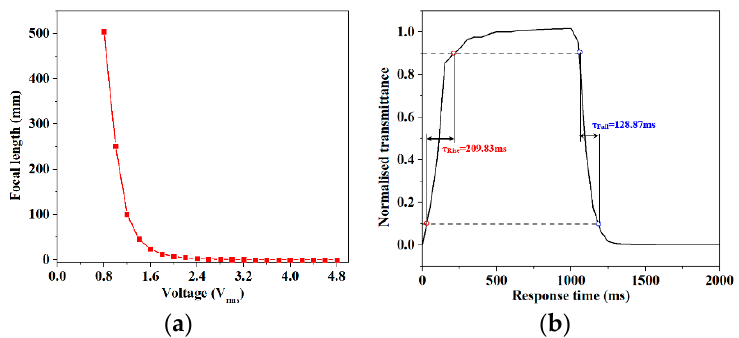
Figure 8. Simulated voltage-dependent focal length and response time curve of the proposed model.